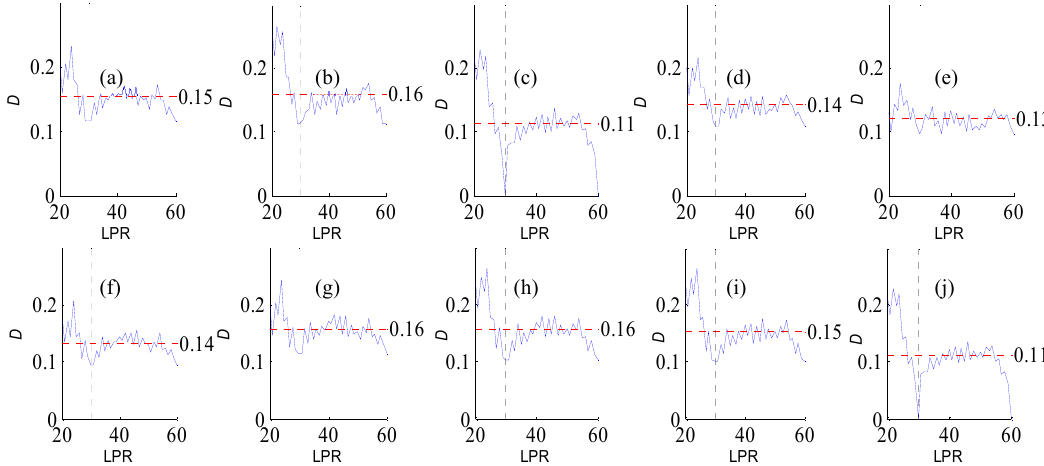
Figure A12. Variation of flow regime alteration degree (D) measured by the RVA with change in the length of post-impact flow time series (LPR) under a periodicity of 30 years. ( a – j ) correspond to pre-impact flow time series length = 21, 26, 30, 34, 39, 43, 47, 51, 56, and 60 years, respectively. The abscissa value for the vertical dotted line is 30. The ordinate value for the horizontal dotted line is the mean degree of flow regime alteration in each subfigure.